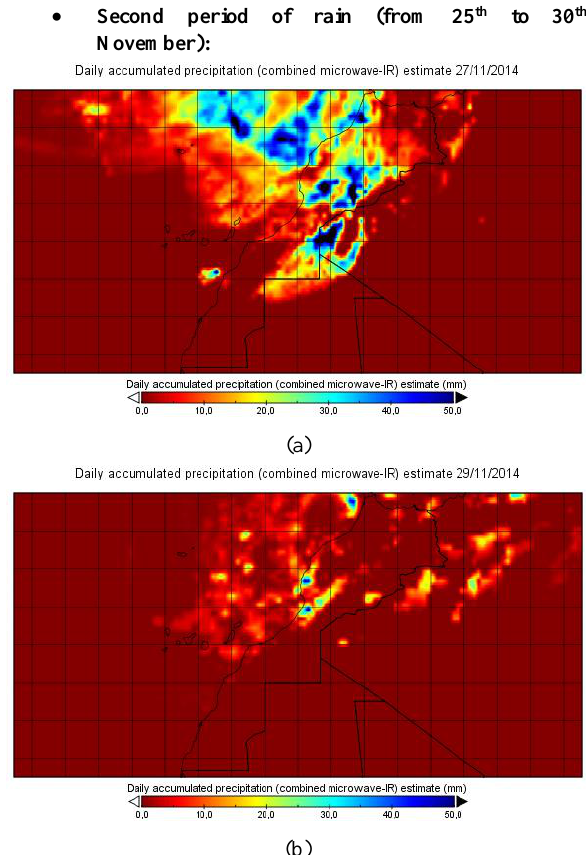
Figure 5. Rainfall maps during the second period of rain on